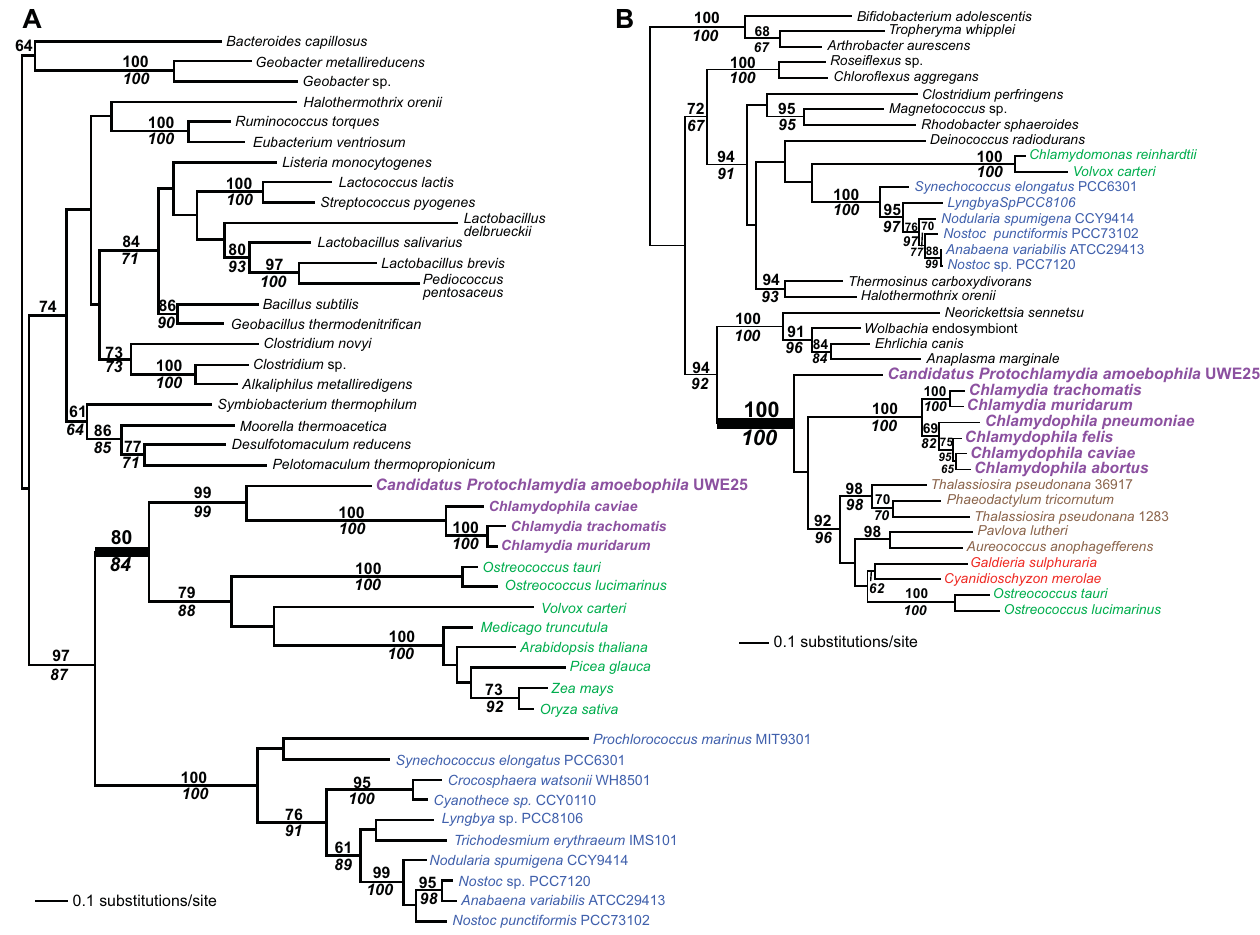
Figure 2. Maximum likelihood (RAxML) trees of Chlamydiae-derived genes in the Plantae. A) The tree of dimethyladenosine transferase (PFC1). B) The tree of queuine tRNA-ribosyltransferase. The results of a bootstrap analysis using RAxML are shown above the branches, whereas PHYML bootstrap support values are shown below the branches. Only bootstrap values $ 60% are shown. Branch lengths are proportional to the number of substitutions per site (see scale bars). Cyanobacteria are shown in blue text, green algae and land plants in green text, red algae in red, chromalveolates in brown, and Chamydiae in magenta. All other bacteria are shown in black text. The thick branches unite Chlamydiae and Plantae.